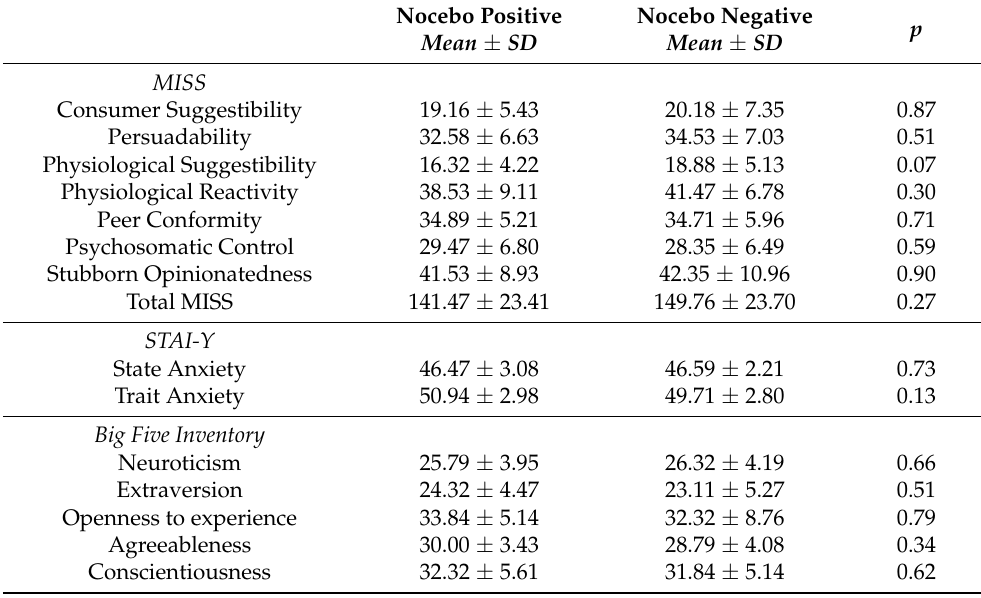
Table 4. Psychological questionnaire scores between patients with and without nocebo